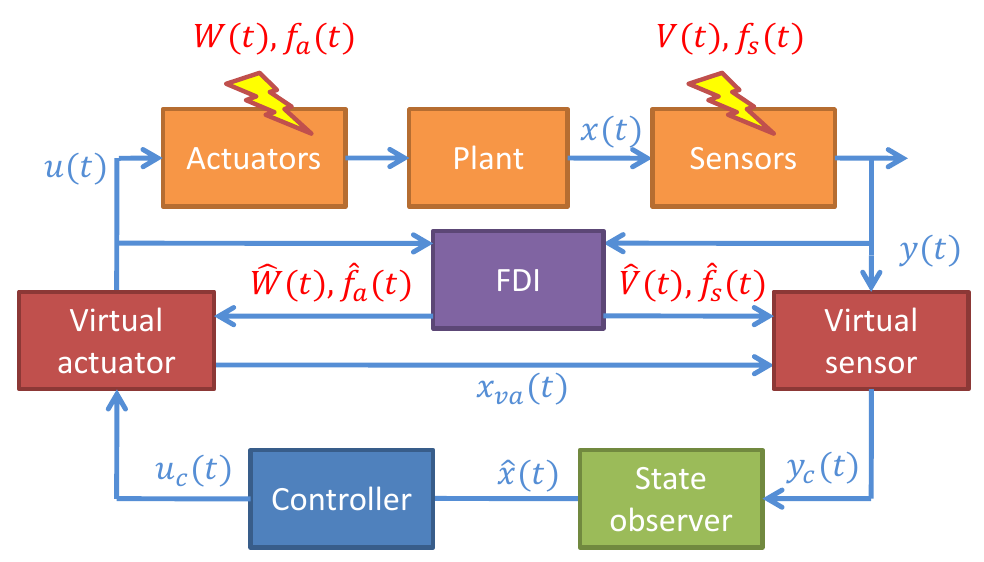
Figure 10. FTC using virtual sensors and virtual